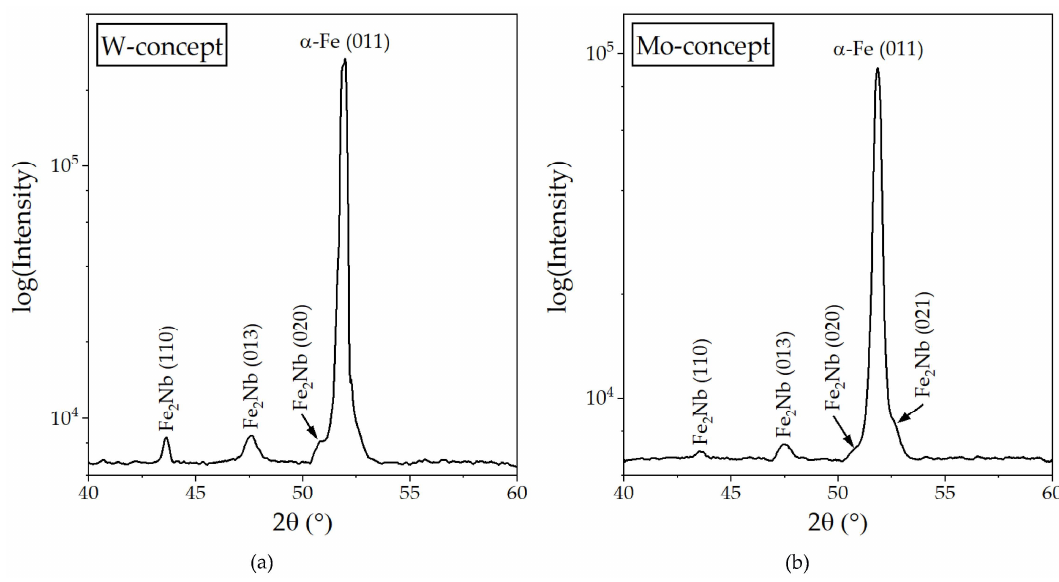
Figure 4. X-ray diffraction patterns of W-( a ) and Mo-concept ( b ) both aged at 650°C for